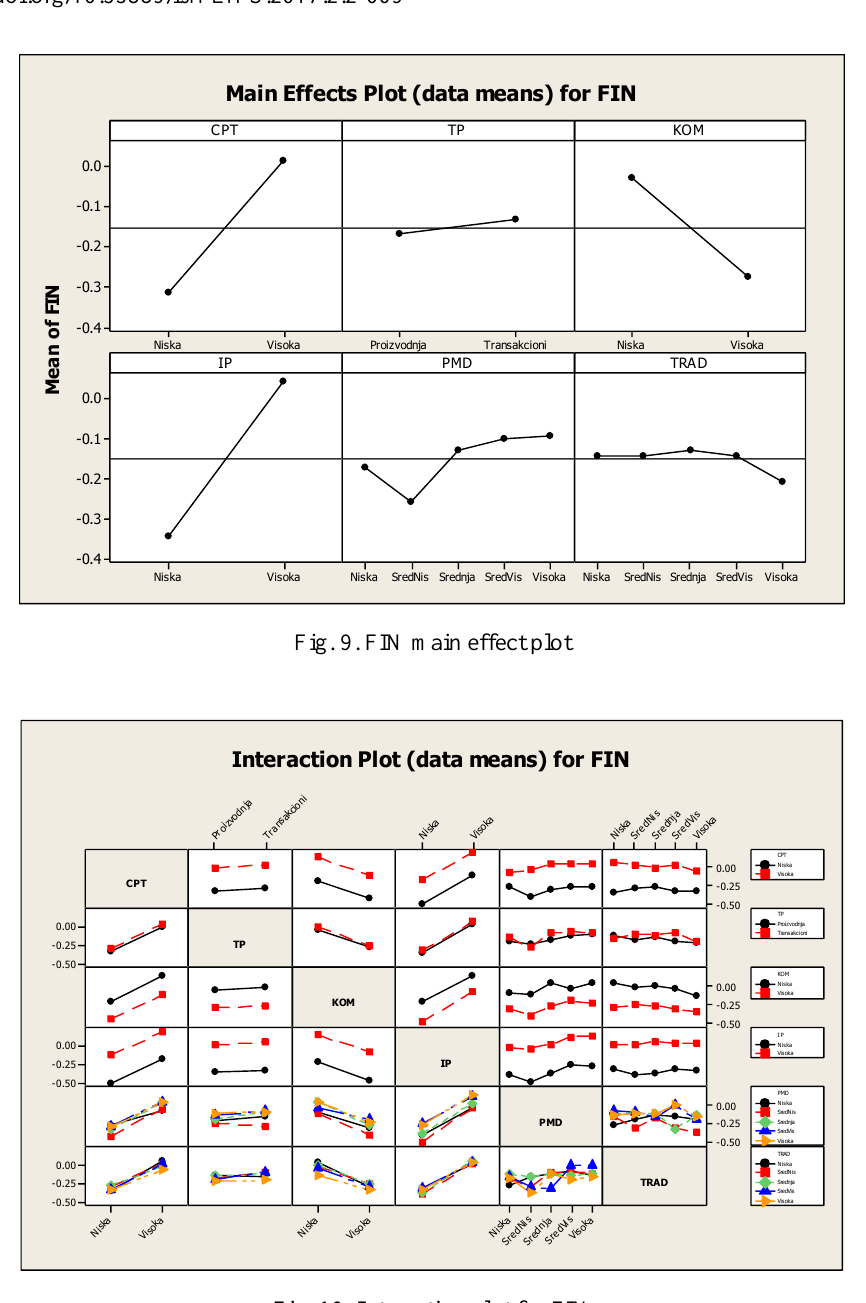
Fig. 10. Interaction plot for